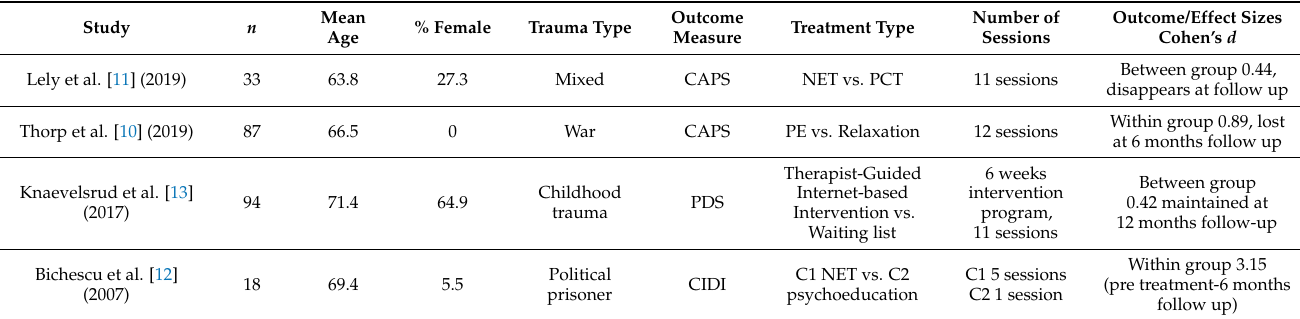
Table 1. Randomized controlled studies of trauma treatment studies including older